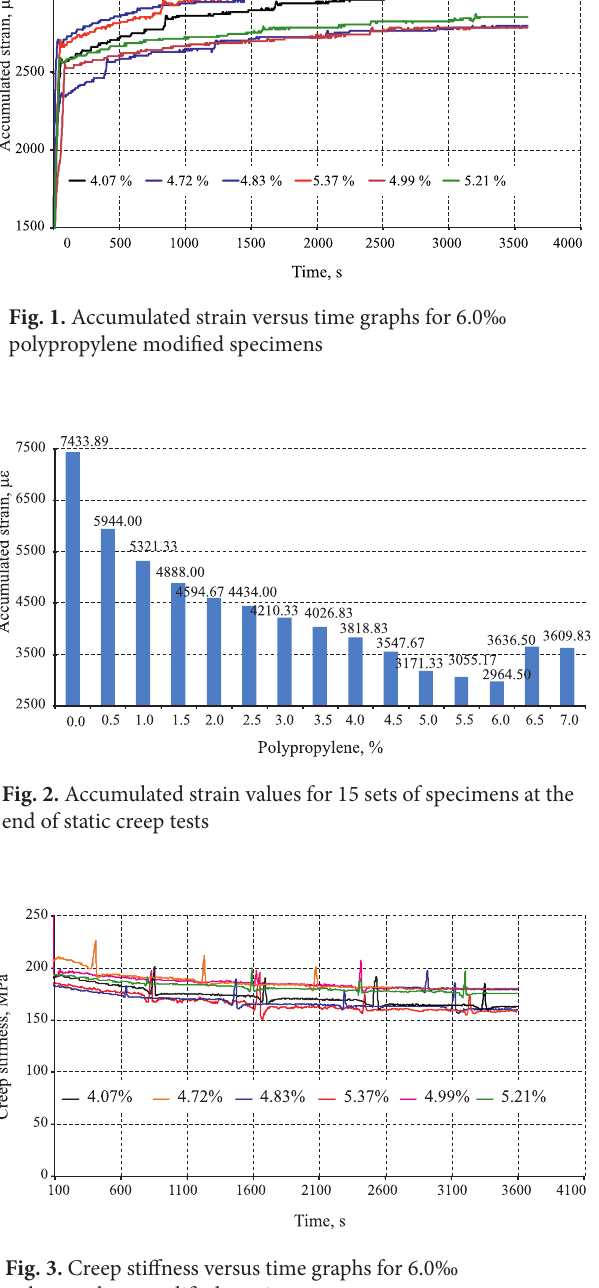
Fig. 3. Creep stiffness versus time graphs for 6.0‰ polypropylene modified